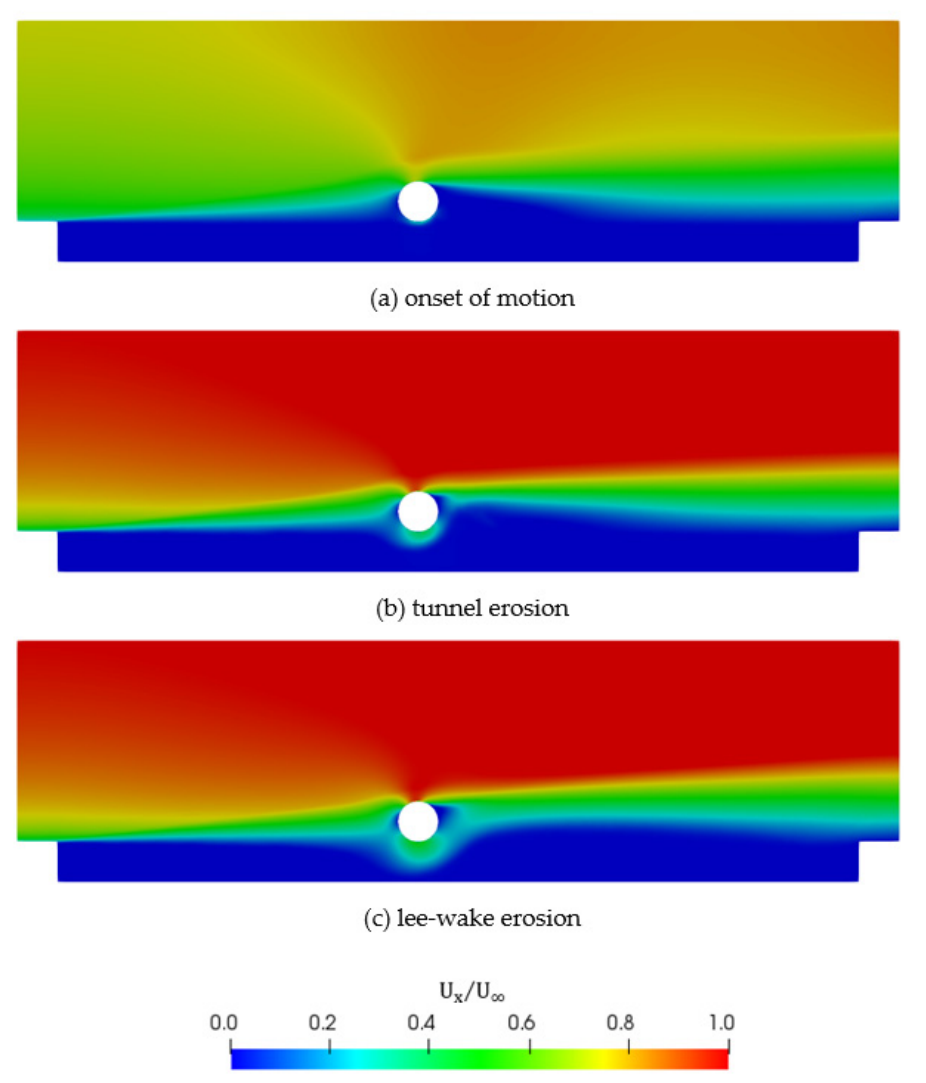
Figure 12. Fluid velocity contours.